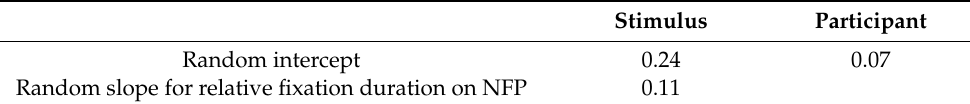
Table 11. ICC random effect terms in mixed-effects model with random slopes for relative fixation duration on NFP in the subset of participants exposed to products with